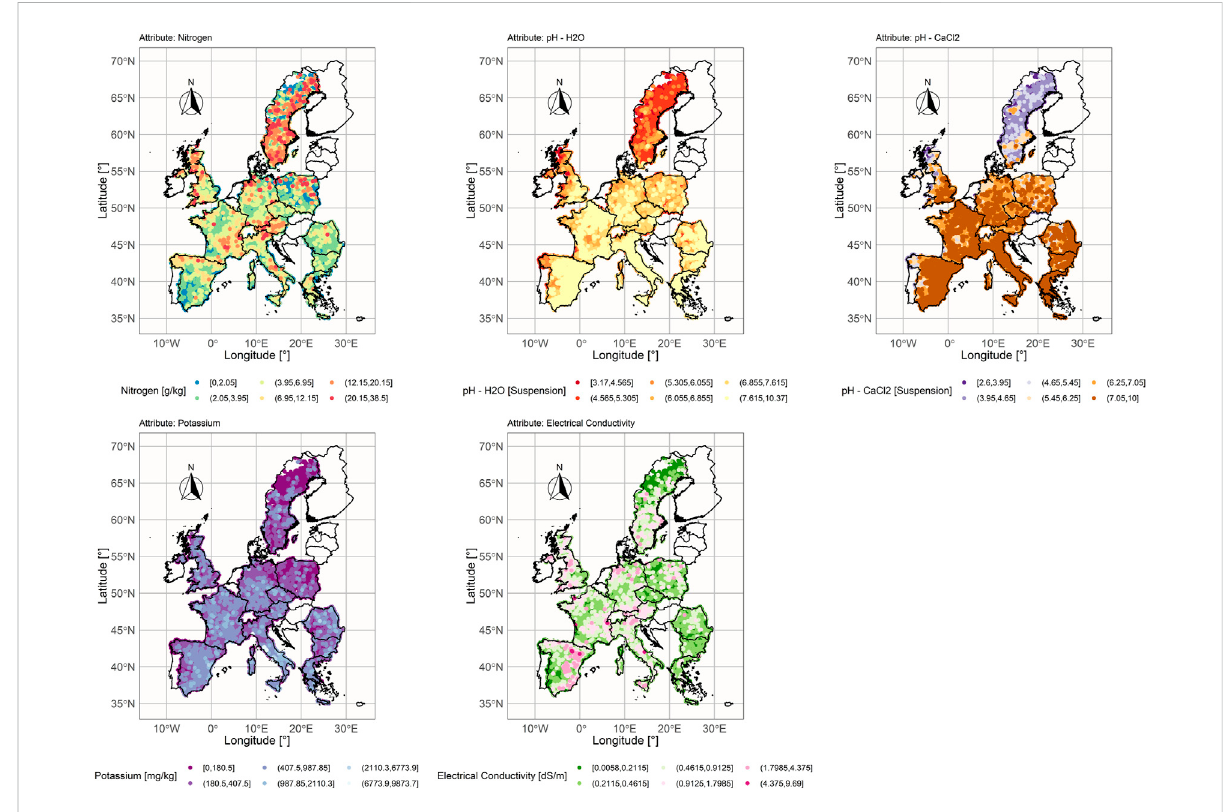
FIGURE 3 Spatial distribution of explanatory variables in a LUCAS-12 data